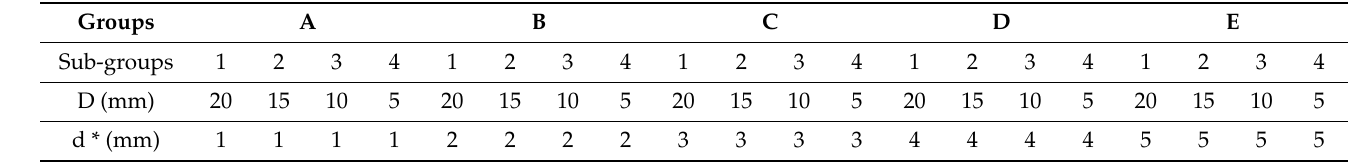
Figure 3. The test piece (hidden and exposed surfaces) and the distribution of artificial defects across its hidden surface. Table 2. The arrangement of depth and size of artificial